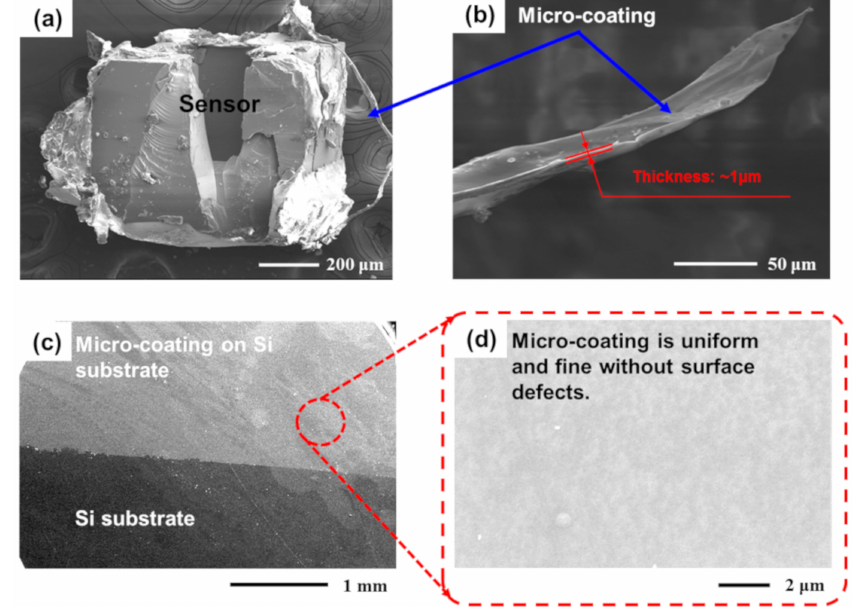
Figure 2. ( a ) A scanning electron microscopy (SEM, Sirion 200, 10 kV) image on the profile of a